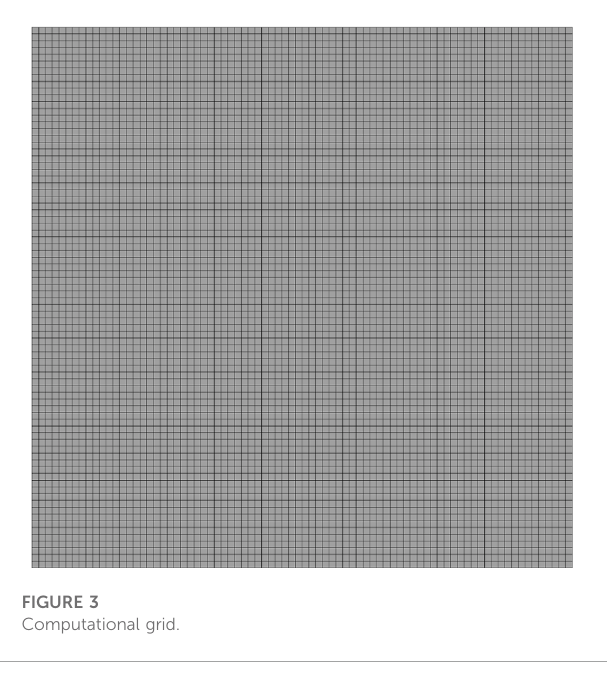
FIGURE 2 Flowchart of the detailed optimization procedure.